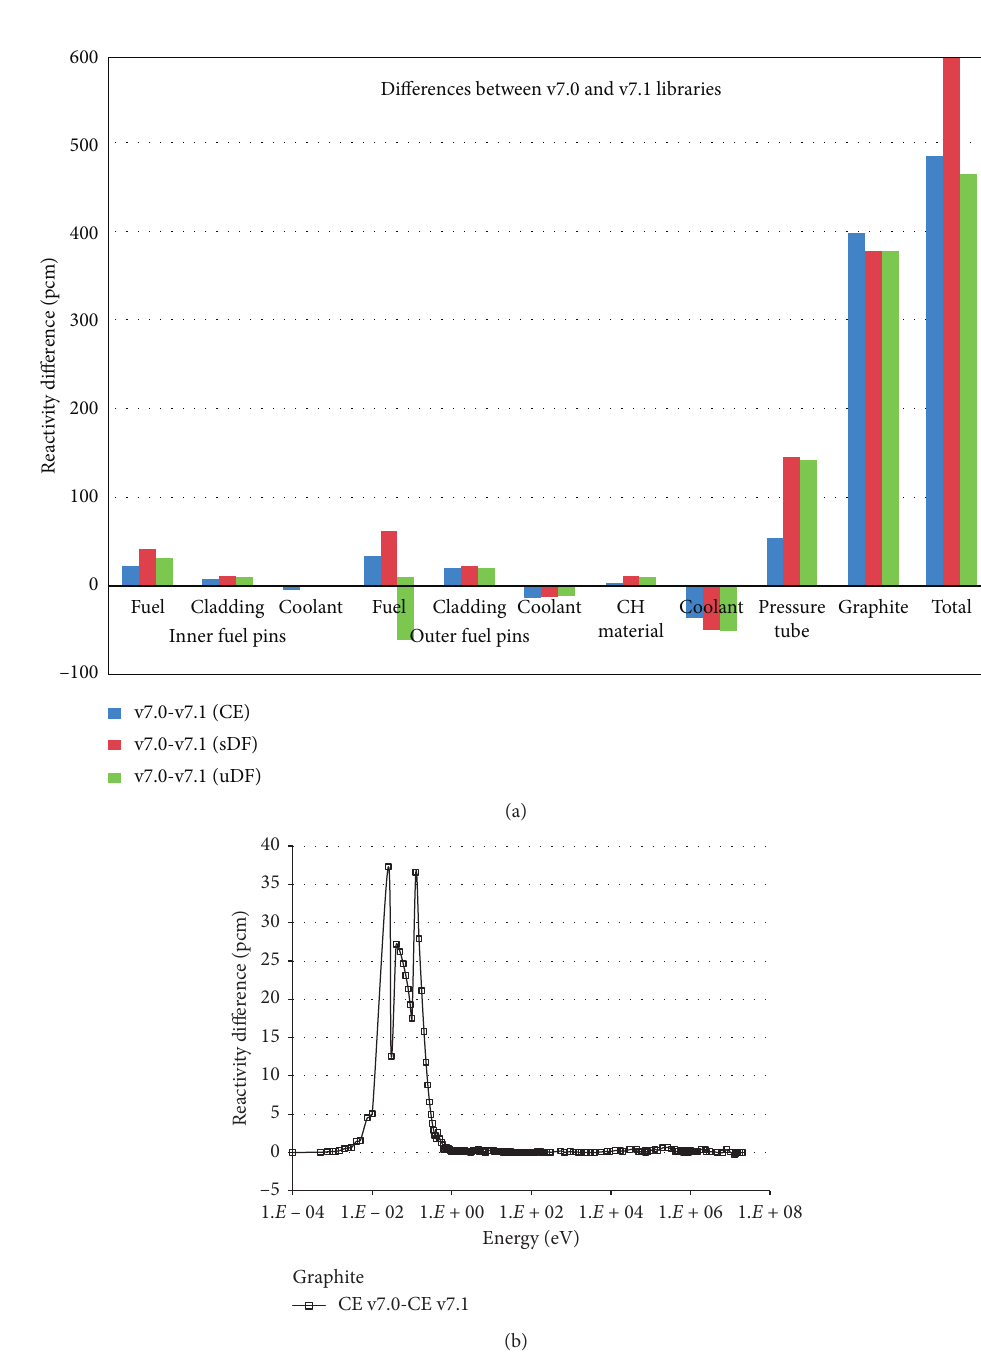
Figure 12: Δ ρ CE7.0-CE7.1 decomposed for separate regions (a) and for separate energy groups in graphite